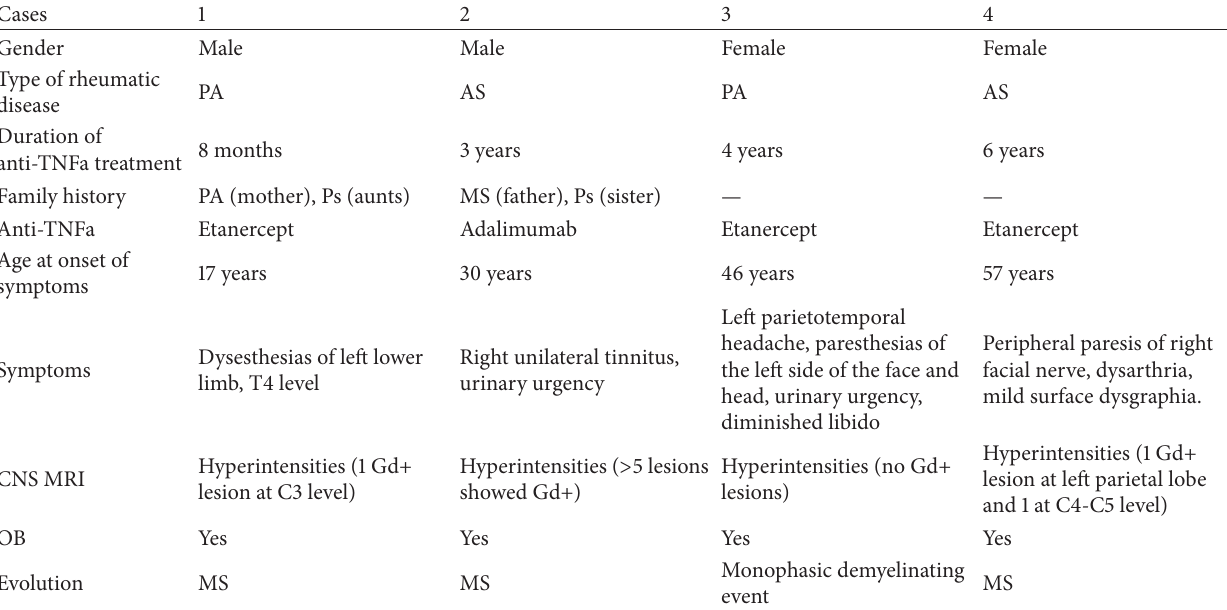
Table 1: Demographical, clinical and imaging data of the four